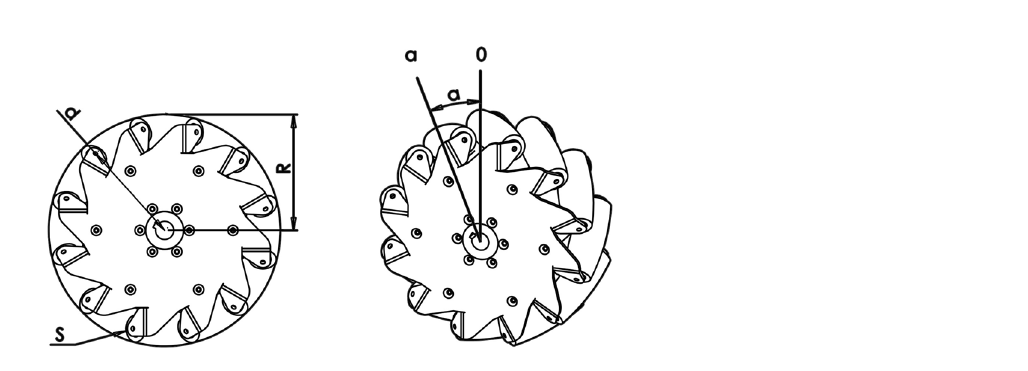
Figure 5. Radius variation for each mecanum